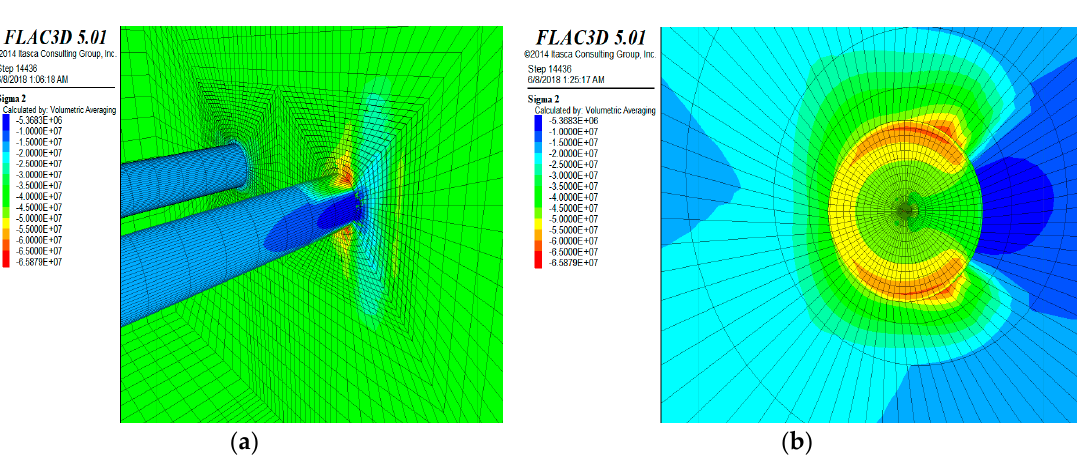
Figure 12. Contours of intermediate principal stress: ( a ) in twin tunnels and ( b ) on the face of right tunnel.